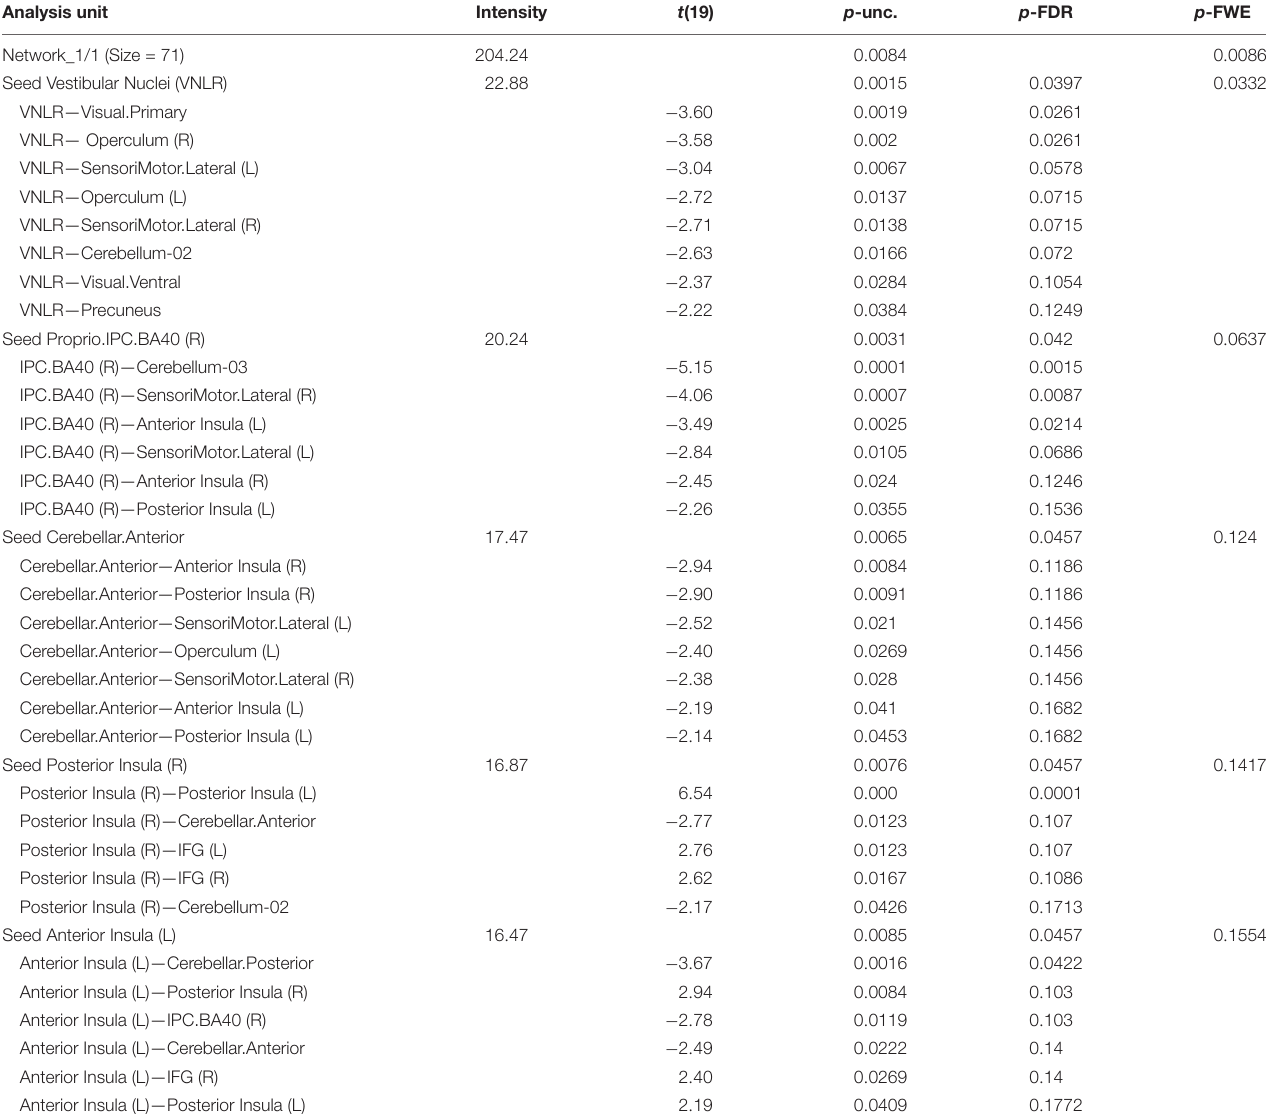
TABLE 4 | Results of the ROI-level NBS analysis (NBS by intensity). Analysis unit